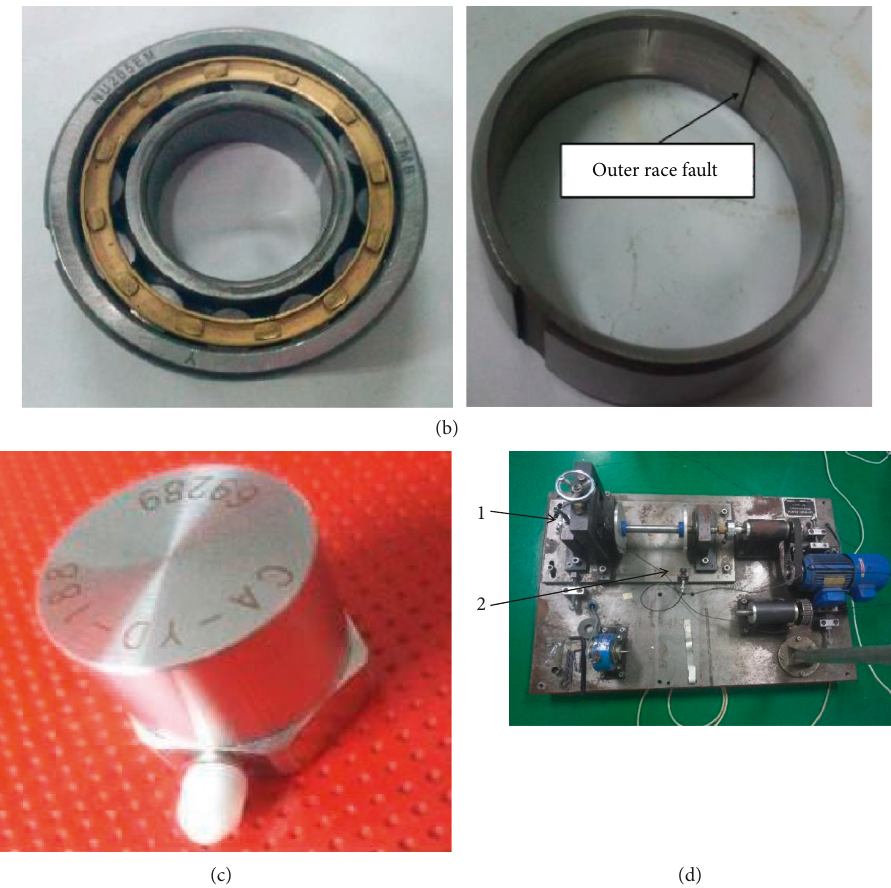
Figure 18: Experimental setup: (a) QPZZ-II fault simulation platform, (b) test rolling bearing, (c) acceleration sensor, and (d) experimental installation.